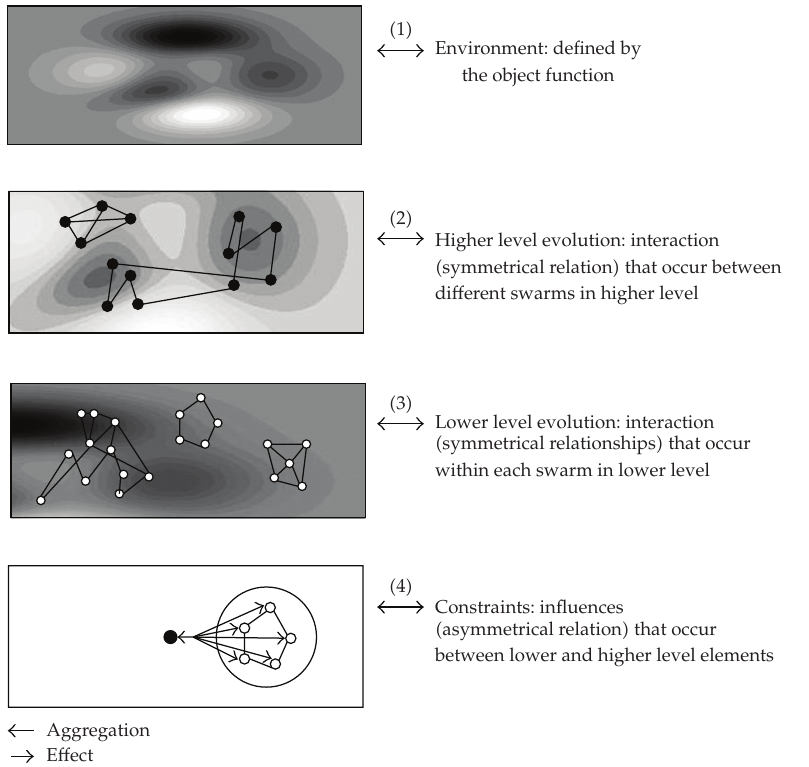
Figure 3: The main functional blocks of the HSO